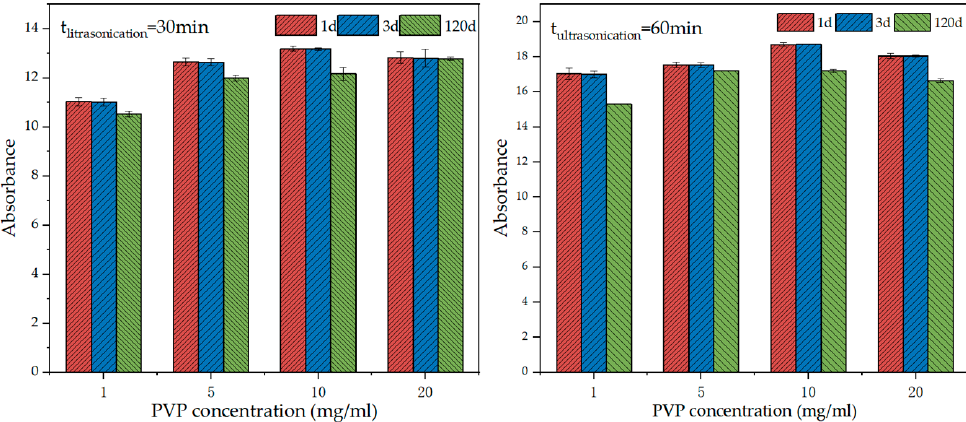
Figure 3. Absorbance of GNPs suspension at different PVP concentrations after various days of resting.